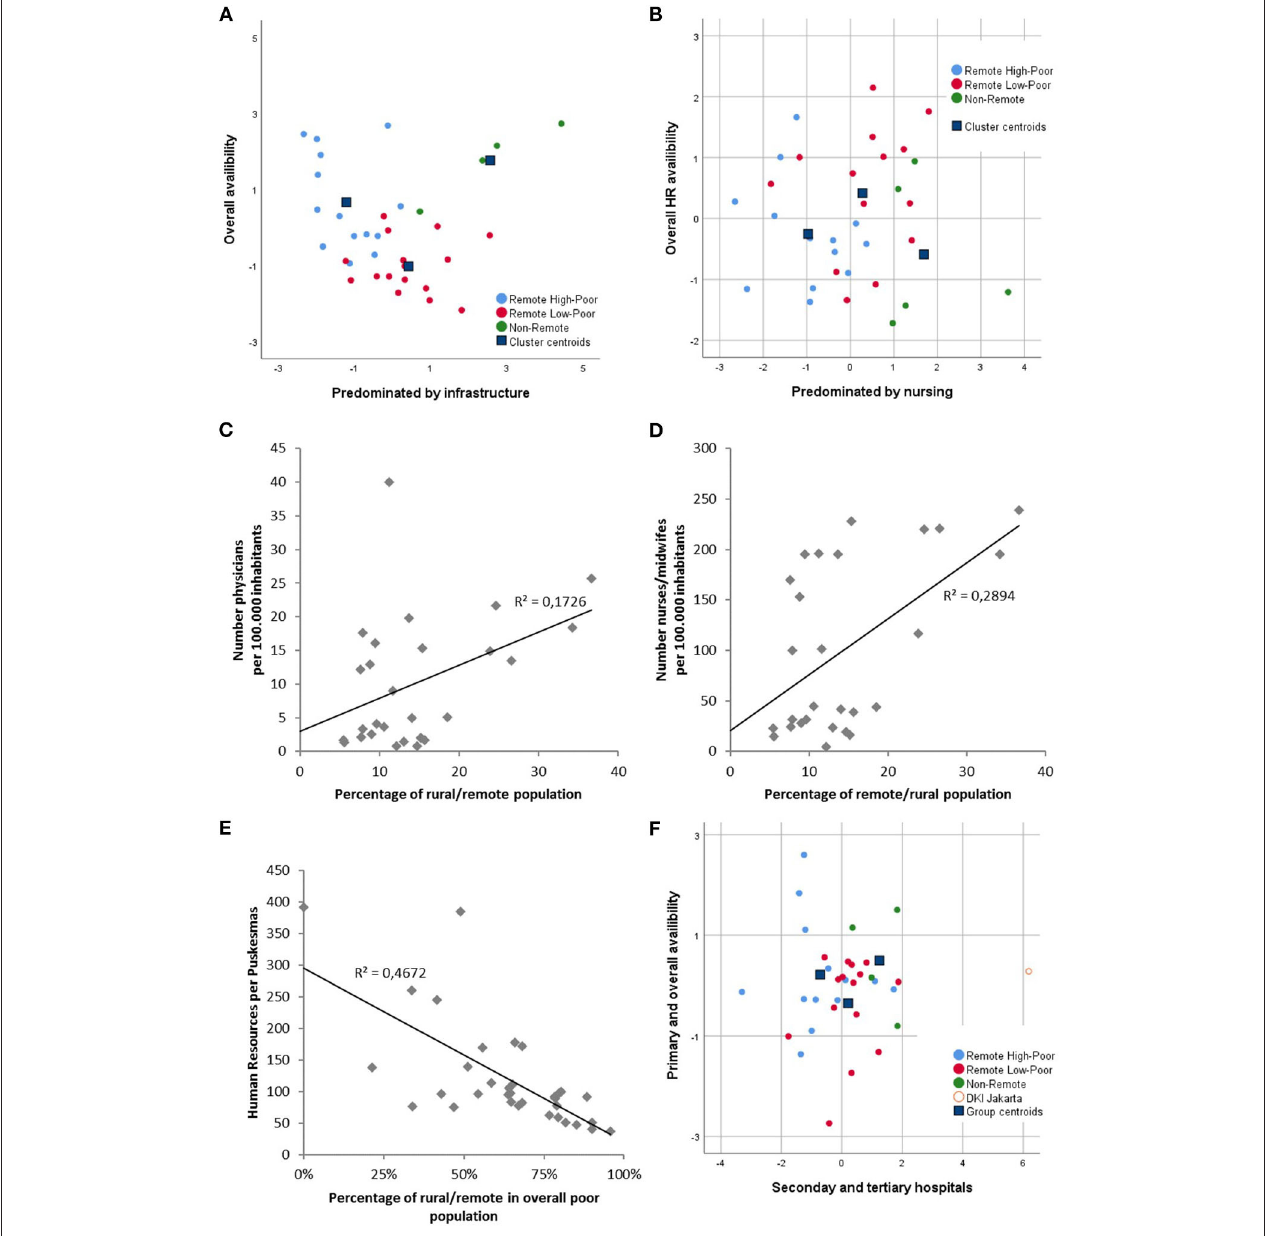
FIGURE 2 | Relationship between healthcare resources and province clusters. Canonical discrimination functions are obtained by infrastructure resource variables for (A) the overall healthcare infrastructure and (B) HRH. Weak correlations between the percentage of remote populations in provinces and the number of available (C) physicians and (D) nurses/midwives in remote regions. (E) Average HRH per puskesmas is related to the percentage of the remote population in the overall poor population. (F) Weak differentiation of canonical discrimination functions using hospital bed